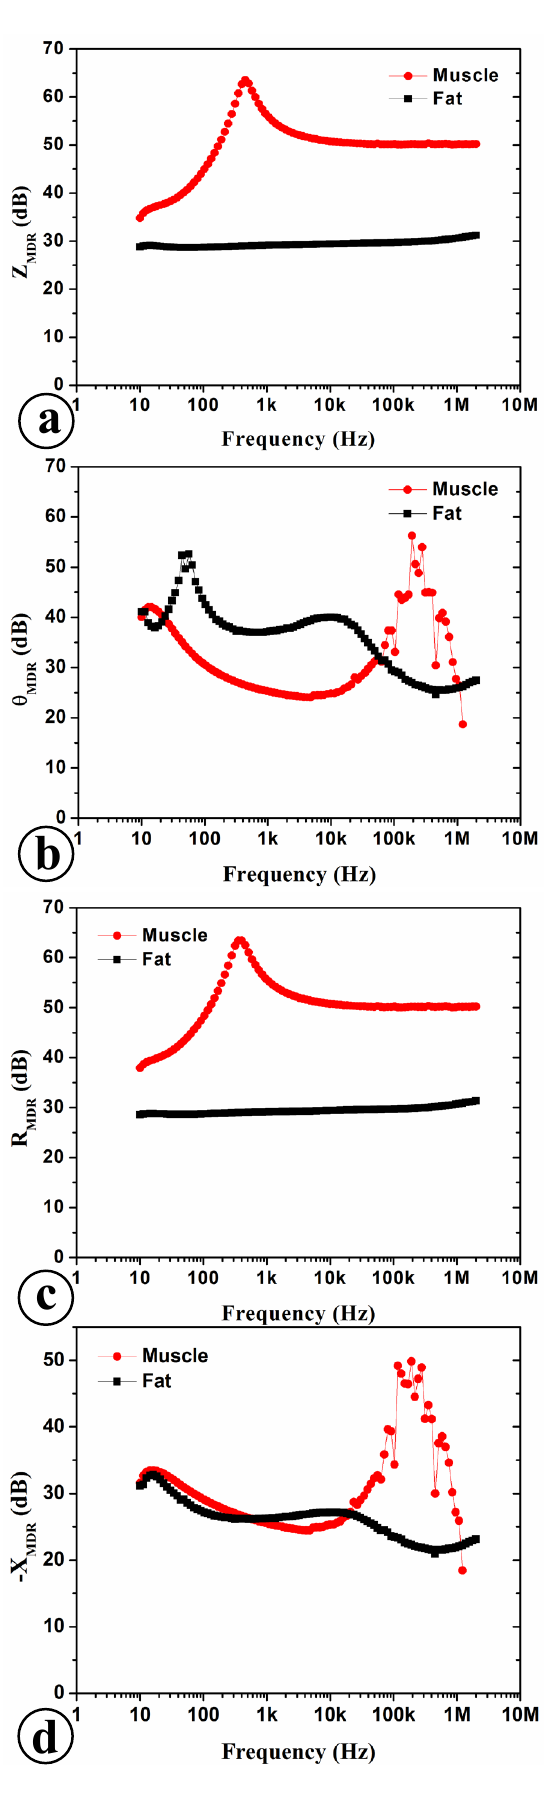
Figure-15: MDR of ρ and σ of chicken muscle tissue paste